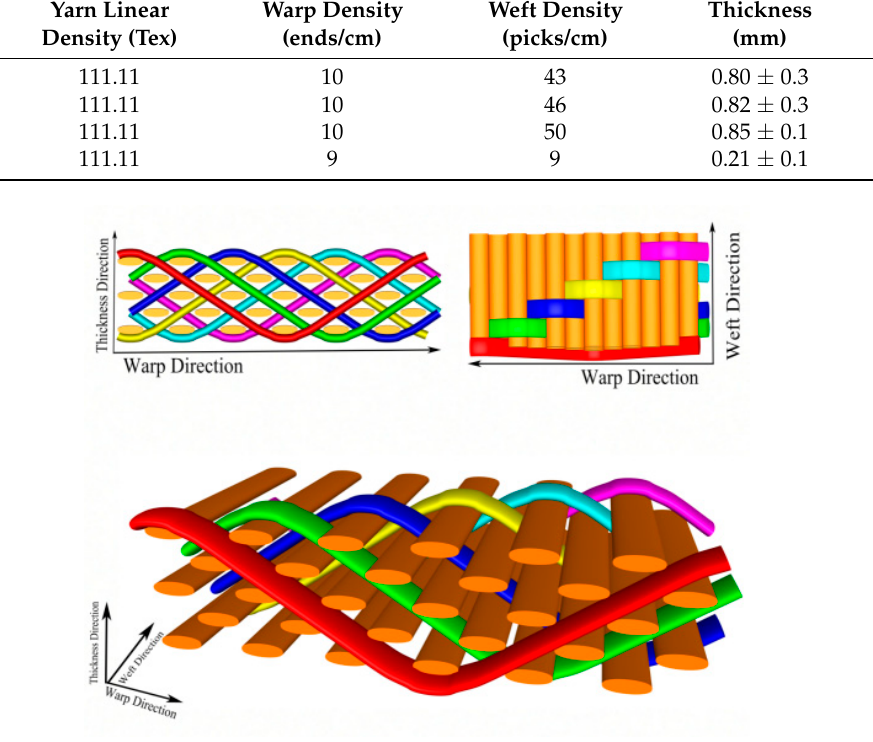
Figure 1. Schematic diagram of 3DDAI fabric.